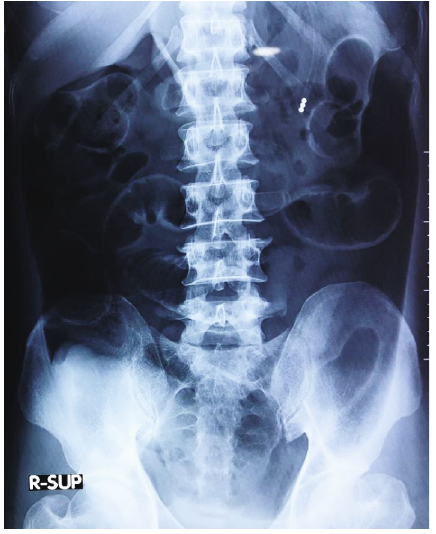
Figure 2: Supine abdominal X-ray shows distended bowel loops with evidence of extramural